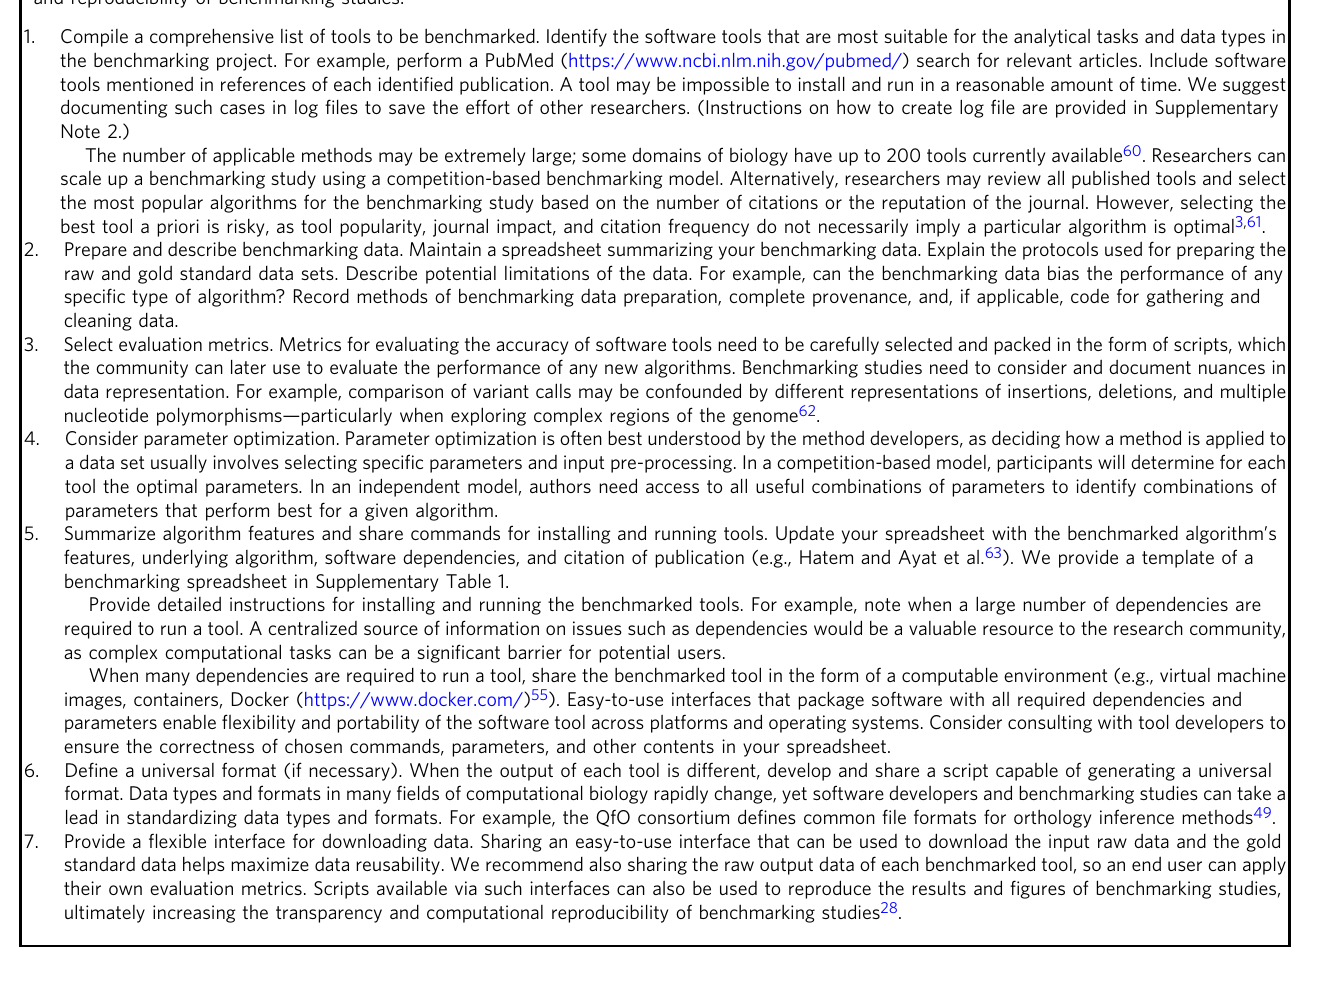
Fig. 1 Study design for benchmarking omics computational tools. to evaluate the accuracy of benchmarked computational tools, results obtained by running the computational tools are compared against the gold standard data (ground truth). First, biological samples are probed by regular measurement protocols (processes that generate omics data) ( a ). Raw omics data generated by these protocols serve as the input for examined computational